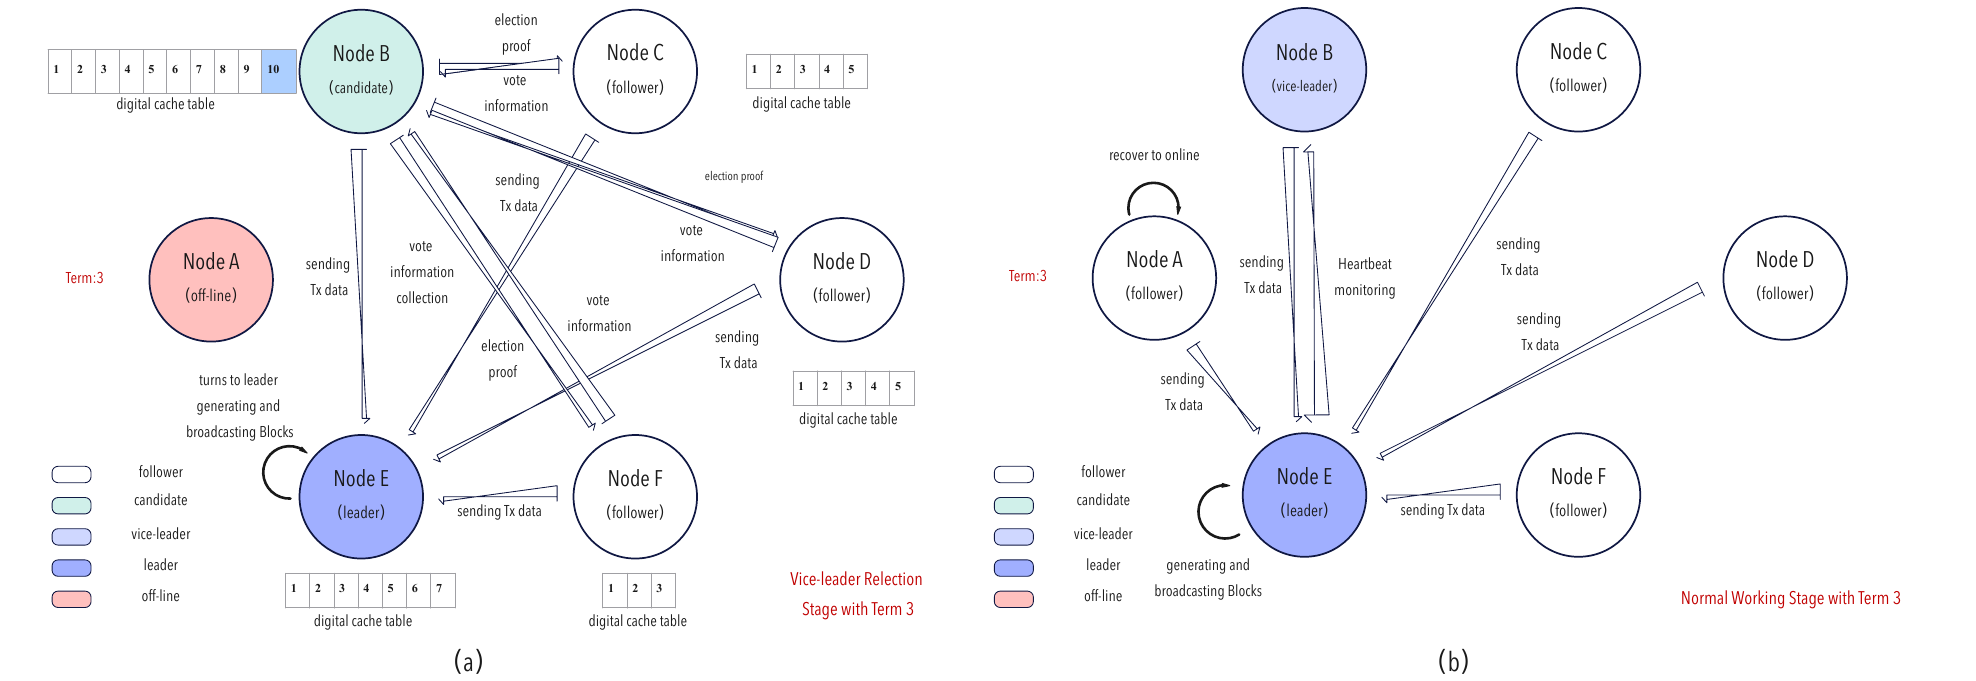
Figure 6. Consensus flow chart: ( a ) VICE-LEADER reelection stage with TERM 3; ( b ) normal working stage with TERM